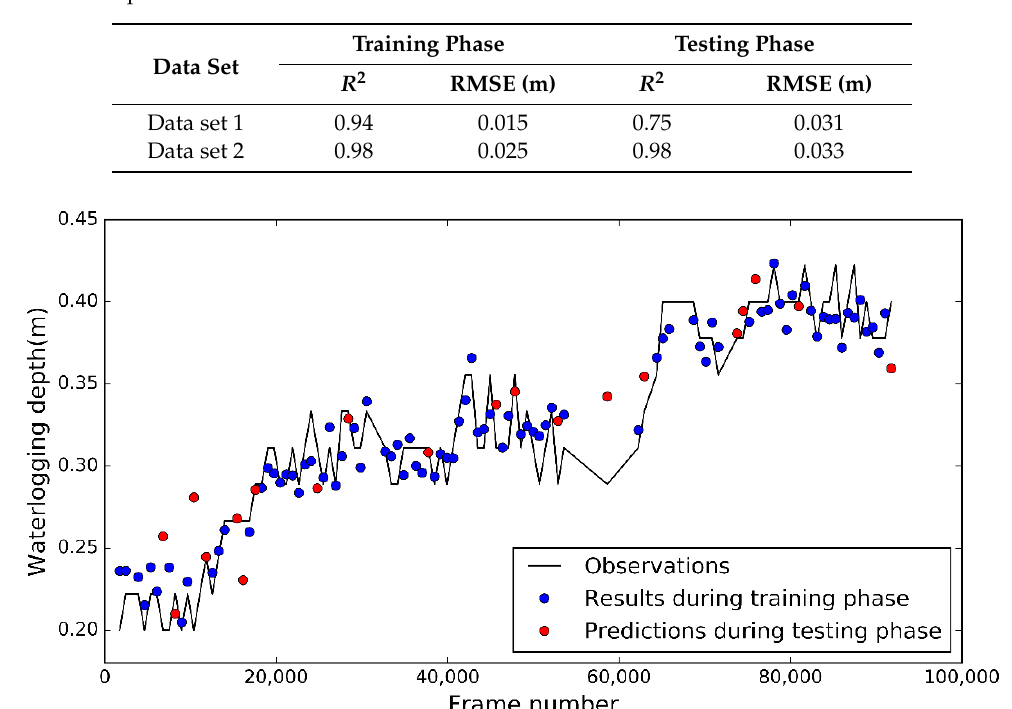
Table 2. The coefficient of determination ( R 2 ) and the root mean square error (RMSE) values of the results and predictions of the lasso models for data sets 1 and 2.